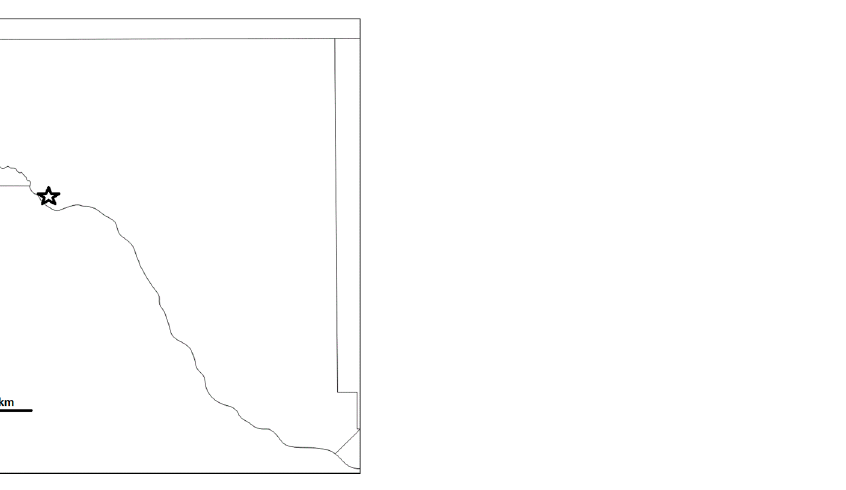
Figure 2. Location of CAMS-12 monitoring site ( star ) within El Paso County, Texas.